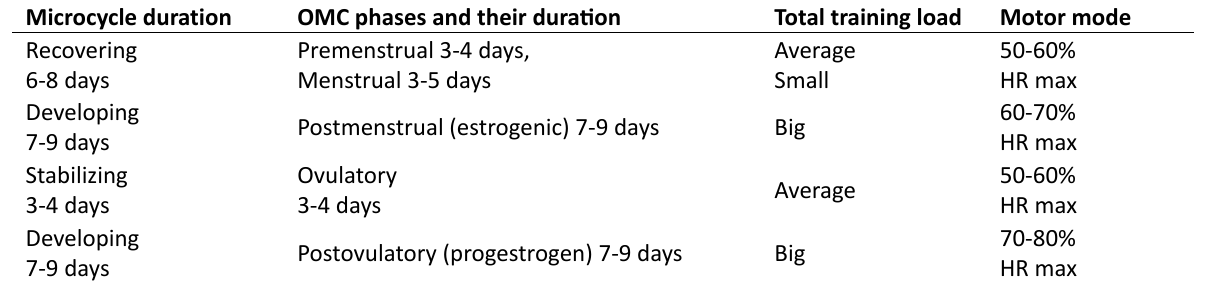
Table 1. Structure of the mesocycle constructed according to biorhythmic phases of women organism. Microcycle duration